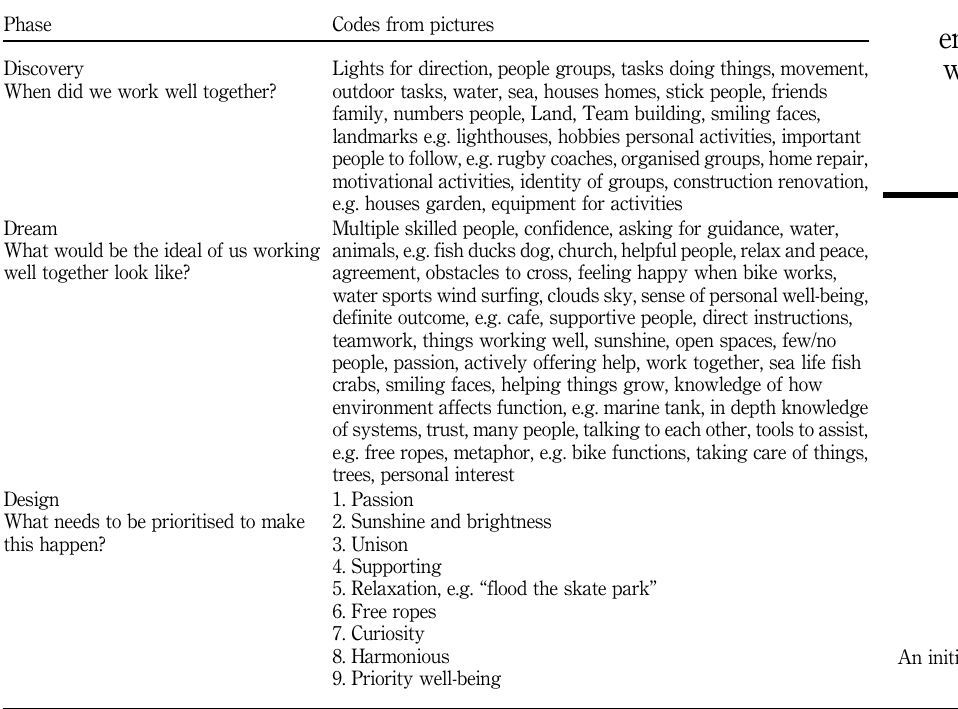
Table I. An initial analysis